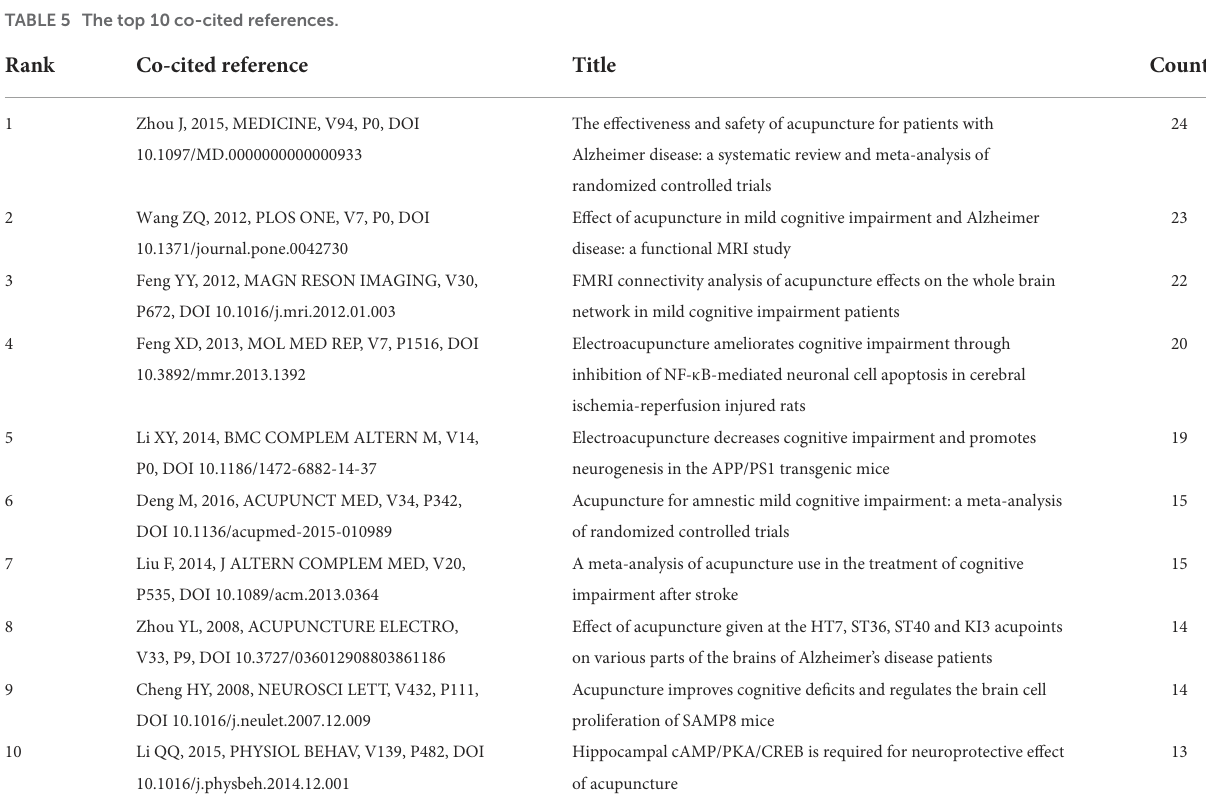
TABLE 5 The top 10 co-cited